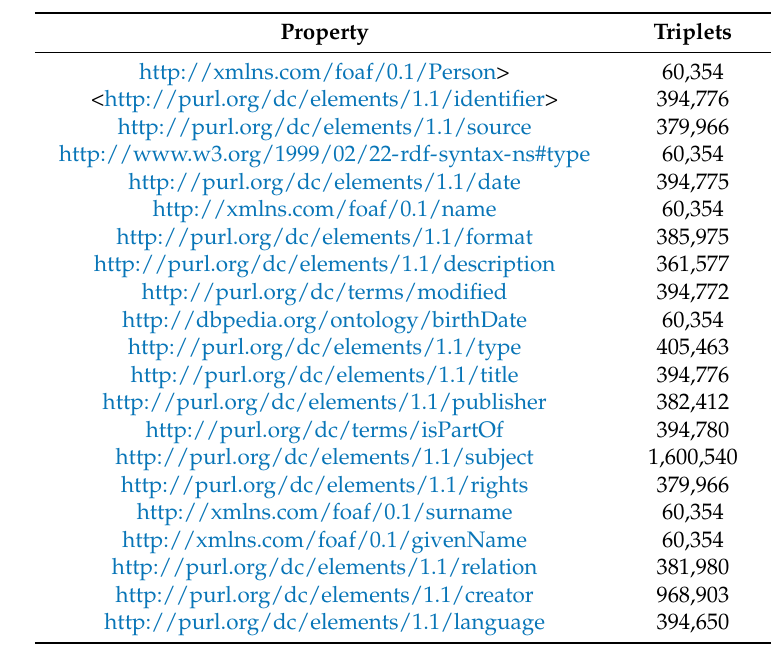
Table 4. Results of loading to TDB.